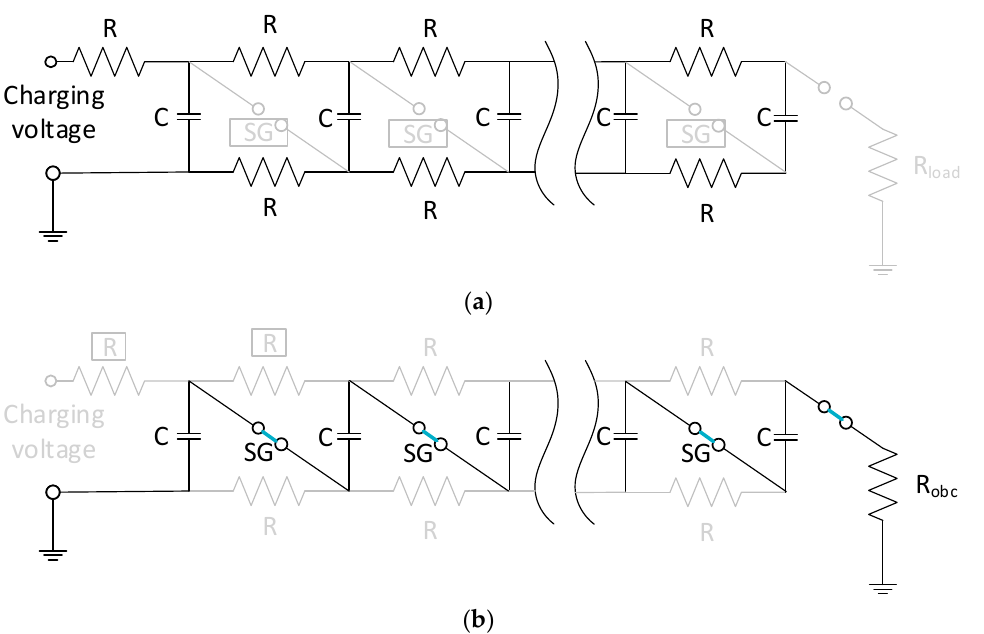
Figure 1. Marx generator electric scheme during the charging phase ( a ) and discharging phase ( b ).